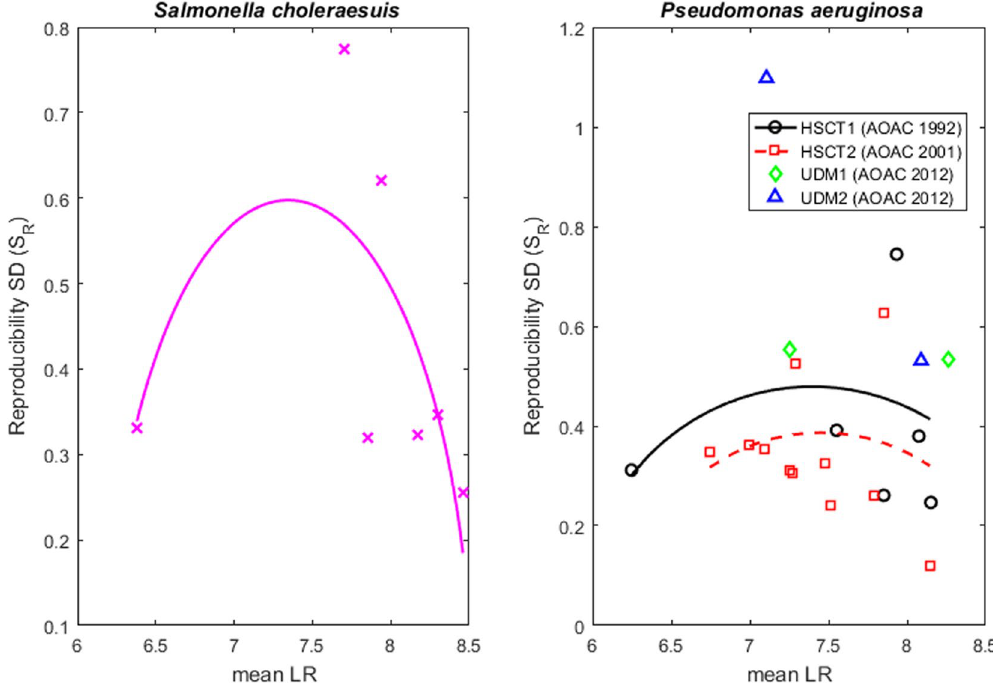
Figure 1. Reproducibility of methods that test antimicrobials against bacteria dried onto a surface. The left pane shows results from a 7-lab study of the HSCT1 that tested agents for efficacy against S. choleraesuis dried onto a surface. The right panel shows results from a 8-lab study of the HSCT1, a 7-lab study of the HSCT2, and a 5-lab study of the UDM1 and UDM2 that tested products for efficacy against P. aeruginosa dried onto a surface. In both panes, each point corresponds to the reproducibility SD (S R ) and mean LR attained by a single product in the multi-laboratory study. The regression curves approximate S R as a frown-shaped function of the mean LR for the HSCT1 and HSCT2. It is not possible to fit a regression curve to data from the UDM1 or UDM2 because only two agents were tested in the associated multi-laboratory studies.